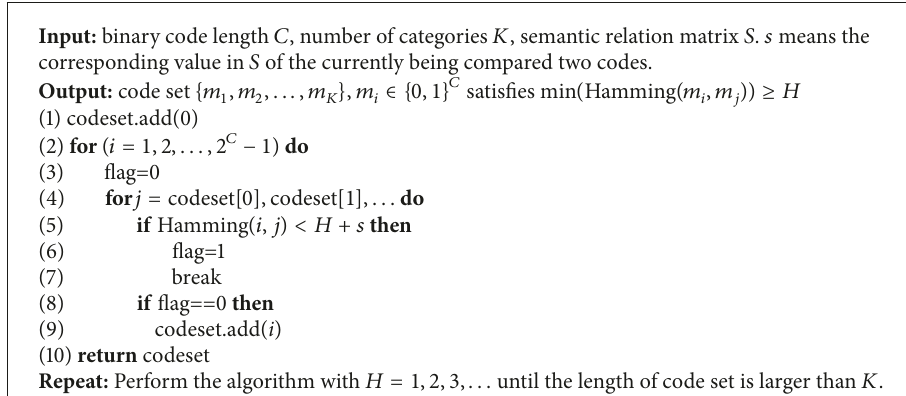
Algorithm 1: Optimal hash code generation.